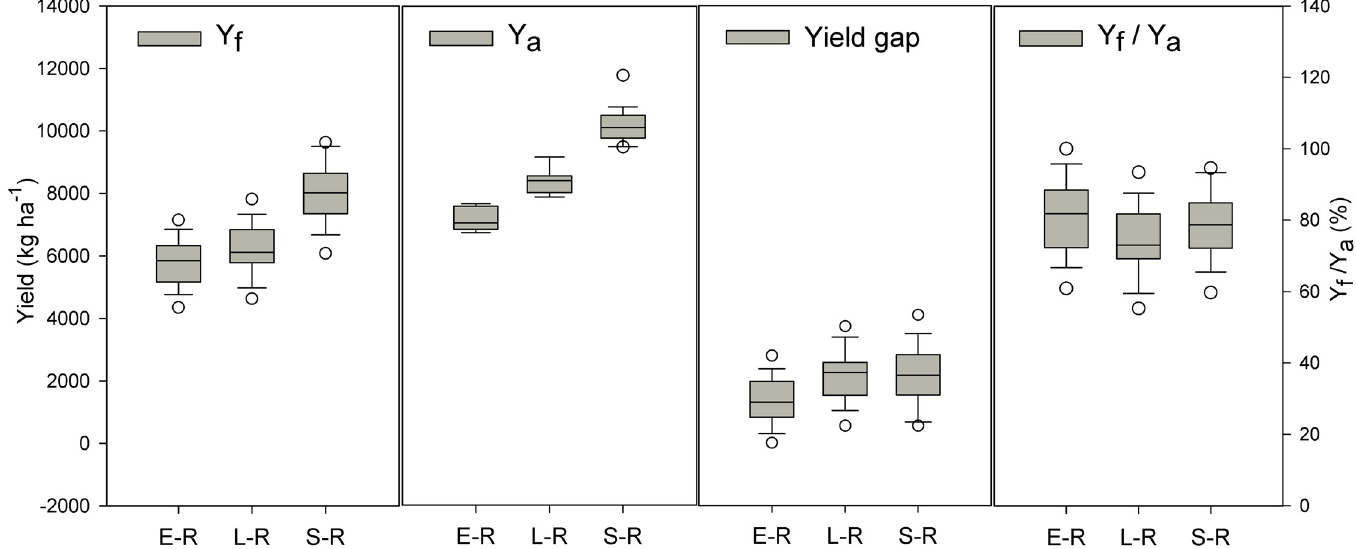
Fig 2. Yield of farming practices (Y f ), attainable yield (Y a ), yield gap and the percentage of Y f as Ya (Y f /Y a ) for three rice faming systems. Note: yield gaps were estimated as differences between yields in farming practice on soils with various productivity levels and ‘ attainable yields ’ , determined as mean yields of the 20% highest-yielding locations under BMPs. E-R, early rice, L-R, late rice, S-R, single rice. Solid and dashed lines indicate median and mean yields, respectively. The box boundaries indicate upper and lower quartiles, the whisker caps indicate 90th and 10th percentiles, and the circles indicate the 95th and 5th